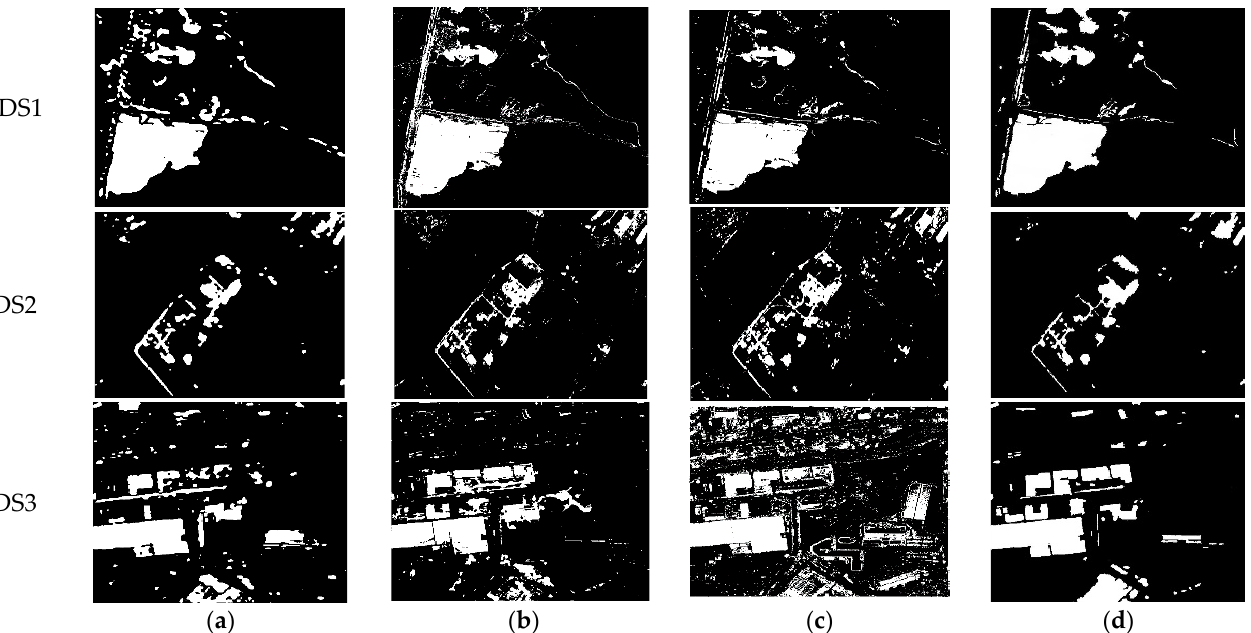
Figure 4. Change detection results in the first experiment: ( a ) co-saliency change; ( b ) spectral change; ( c ) spatial change; and ( d ) proposed method.